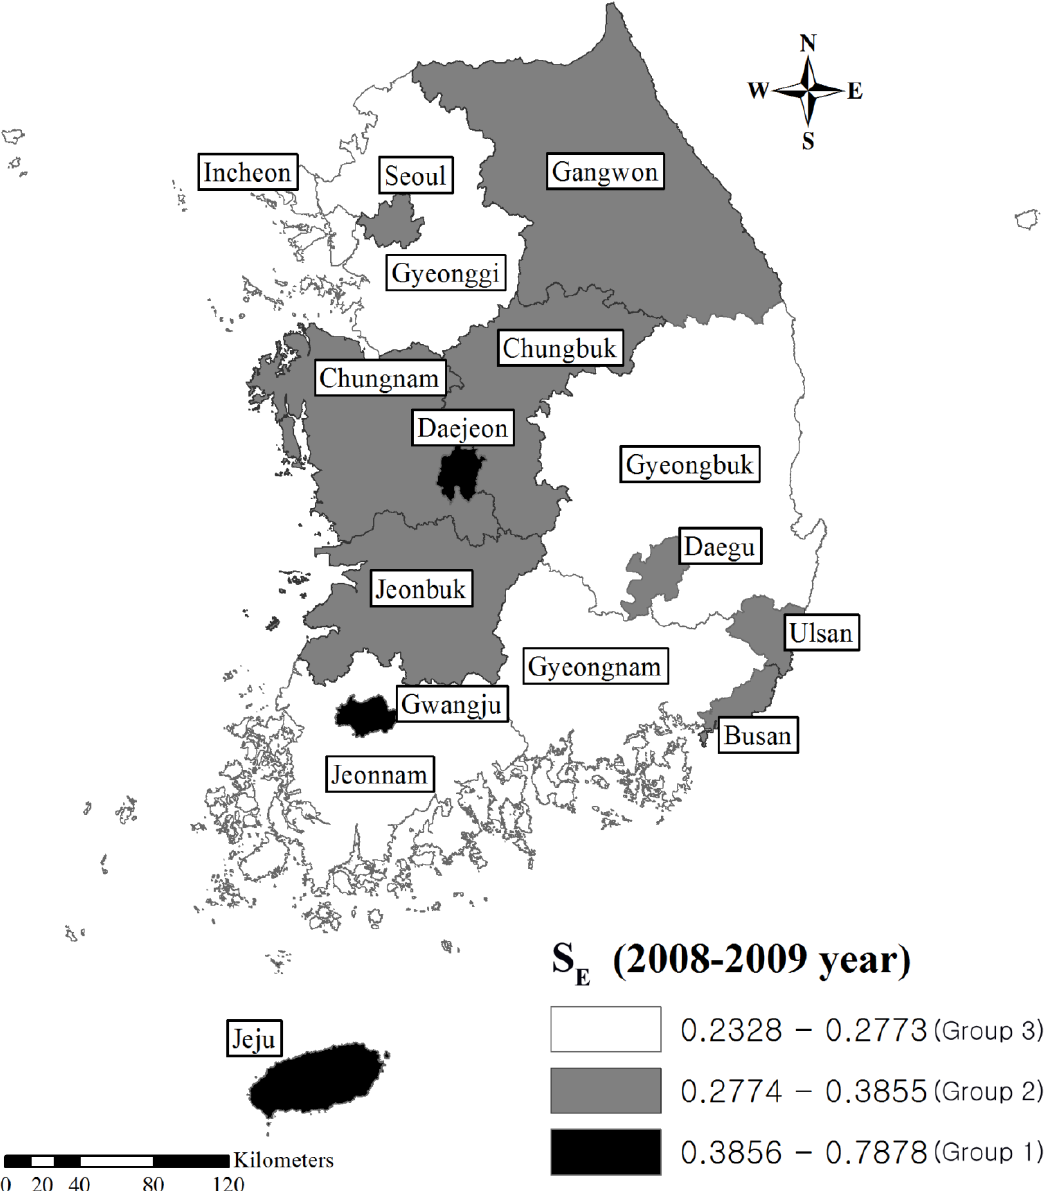
Figure 1. Classification of the synthesized measure of Environmental Indicators of Korean administrative areas